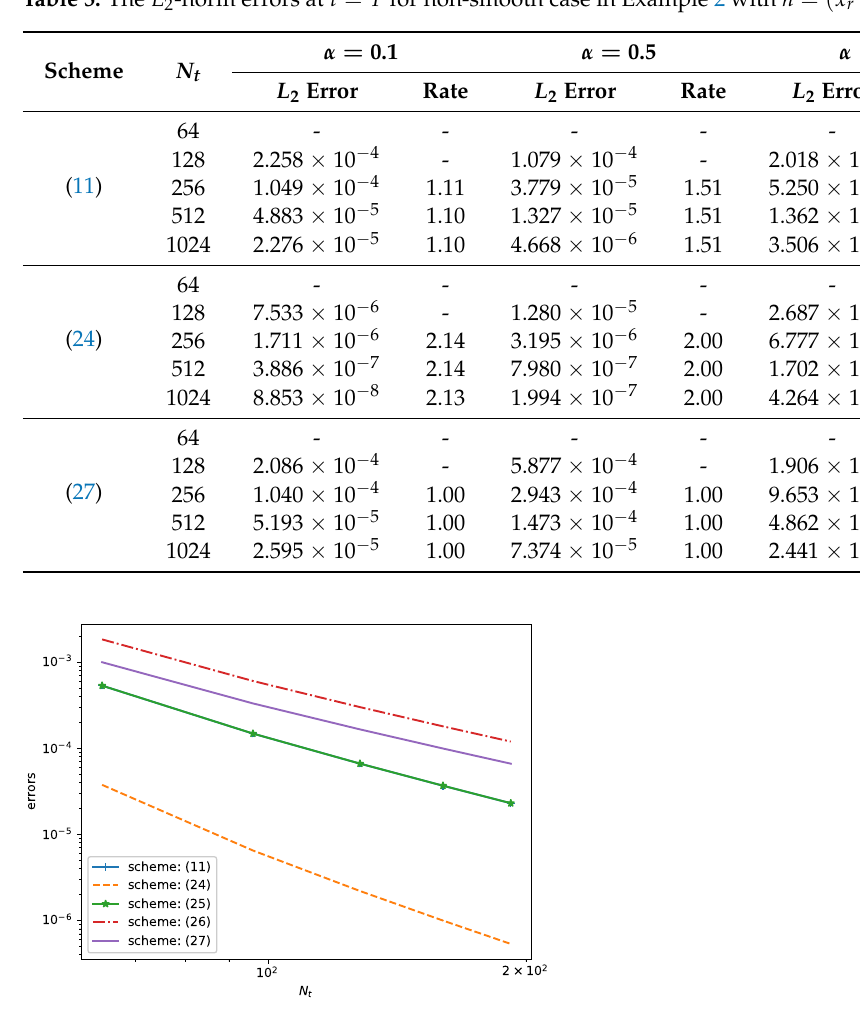
Figure 1. Comparison of the L 2 -norm errors for different finite difference schemes with fixed α = 0.3.